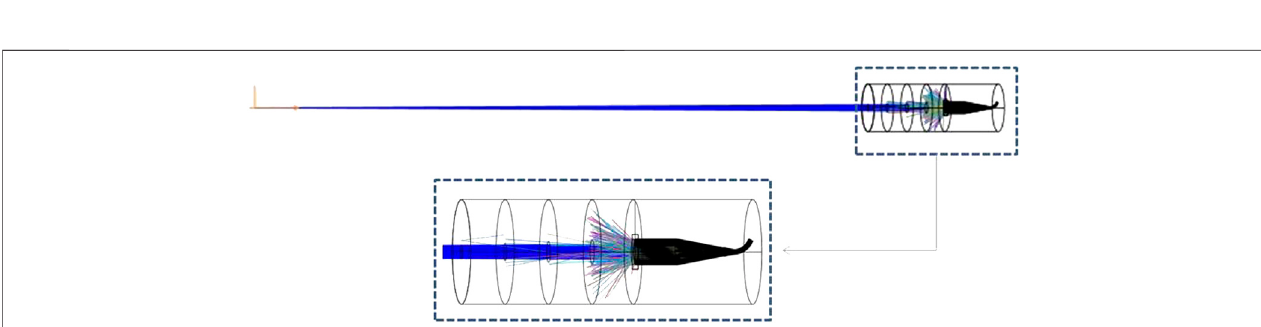
FIGURE 9 | Schematic overview of NSC source, aperture and detector layout simulated in Zemax OpticStudio.